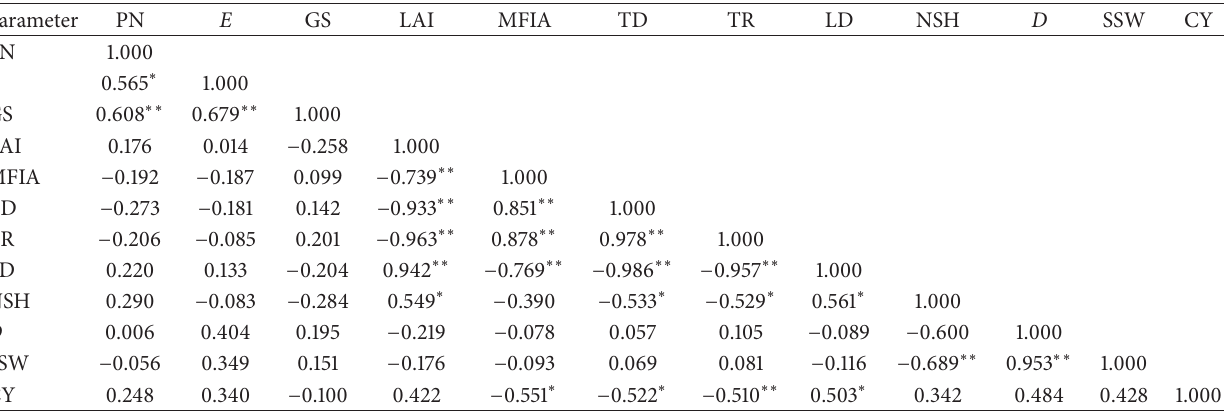
Table 8: Correlation matrix among the traits in sugarcane